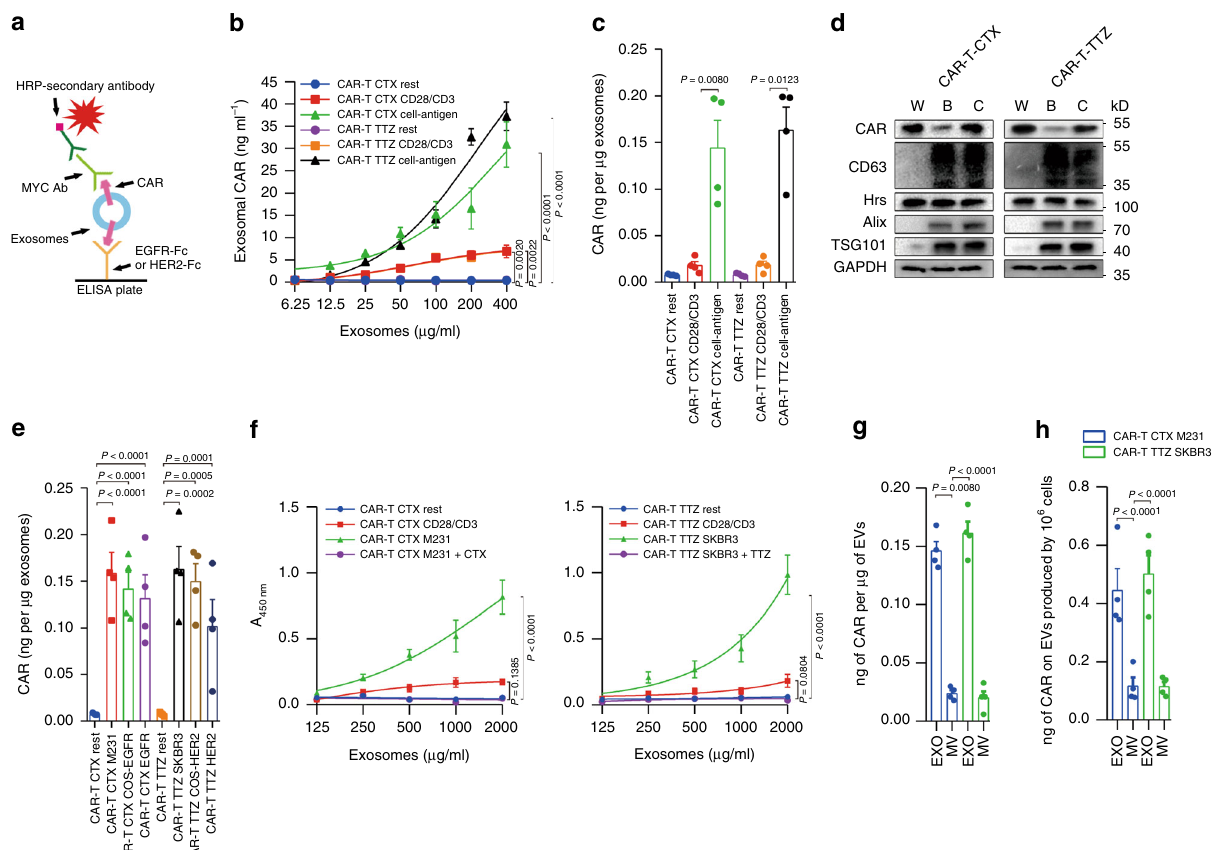
Fig. 2 CAR-T cells release extracellular vesicles carrying CAR protein. a , b Schematic ( a ) of ELISA ( b ) to measure the CAR concentration on the surface of exosomes isolated from CAR-T cells of different states. c ELISA of CAR on exosomes from CAR-T, with or without antigen stimulation. d Immunoblots for CAR expression in whole-cell lysates (W) and puri fi ed exosomes from CAR-T cells with CD28/CD3 bead stimulation (B) or cancer cell stimulation (C). All lanes were loaded with the same amount of total protein. e ELISA of CAR on exosomes from CAR-T with or without different stimulation strategies. f Antigen binding of exosomes from different cultures with or without blocking antibody cetuximab (CTX) or trastuzumab (TTZ). g Levels of CAR on the exosomes or microvesicles derived from CAR-T cells as assayed by ELISA. h Levels of exosomal CAR and microvesicle CAR produced by an equal number of CAR-T cells. Results shown represent three ( d ) independent experiments. Data are the means ± s.d. of four independent biological replicates ( b , c , e , f , h ). P values are from a two-way ANOVA followed by the Bonferroni post-test ( b , f ), one-way ANOVA followed by Tukey ’ s post-test ( c , e ) or a two-sided unpaired t test ( g , h ). Source data ( b – h ) are provided as a Source Data fi